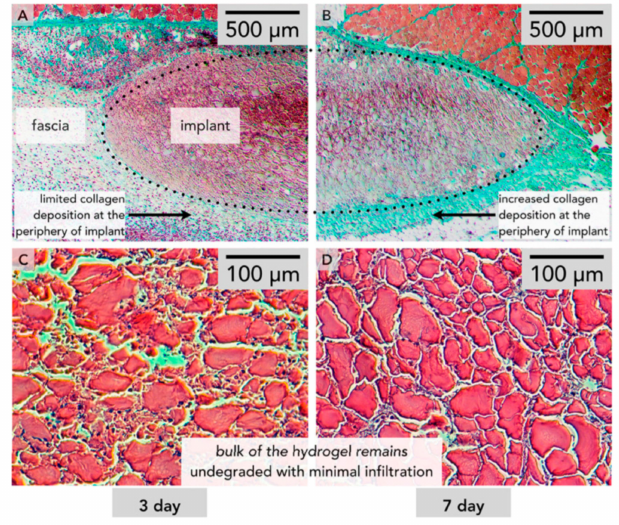
Figure 7. Histology of a self-assembled peptide hydrogel with mMA encoded within after 3 days ( A , C ) and after 7 days ( B , D ). ( C ) and ( D ) show close to no cellular growth within the gel matrix